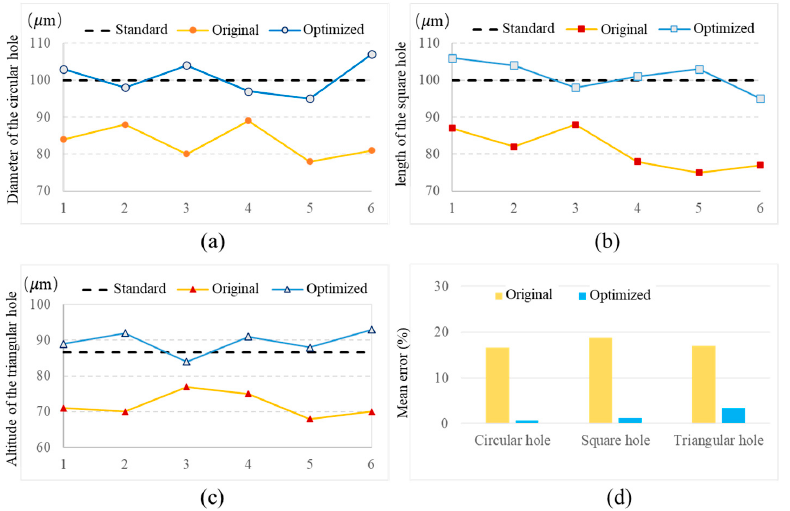
Figure 9. The 3D printing results of the hole features. ( a ) the designed pattern for the circular hole, ( b ) the designed pattern for the square hole, ( c ) the designed pattern for the triangular hole, ( d ) the optimized pattern for the circular hole, ( e ) the optimized pattern for the square hole, ( f ) the opti- mized pattern for the triangular hole. scale bar: 25 µm.